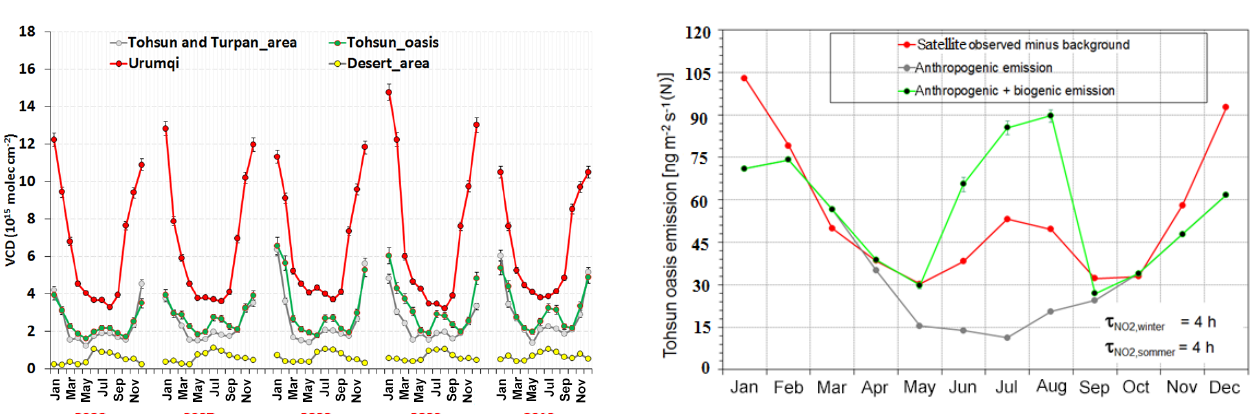
Figure 11. Monthly mean top-down emissions (from satellite ob- servations) are compared to bottom-up (soil biogenic and anthro- pogenic) and anthropogenic emissions (in terms of ngm − 2 s − 1 , N). The biogenic bottom-up emissions around 13:00LT (at satel- lite overpass) are selected. They are systematically higher than the daily averages (see Fig.